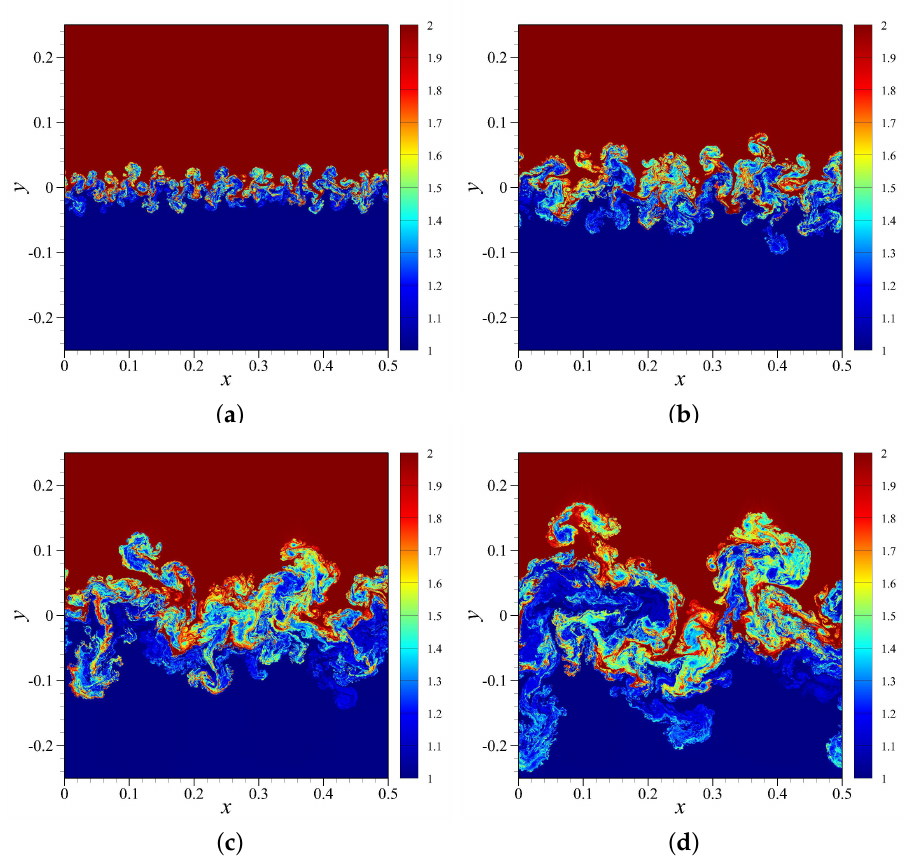
Figure 3. Time evolution of density field for the RTI problem with multi-mode perturbation: ( a ) t = 1.6; ( b ) t = 2.4; ( c ) t = 3.2; ( d ) t = 4.0. Results are obtained by the ILES-Roe scheme at a resolution of 16384 ×